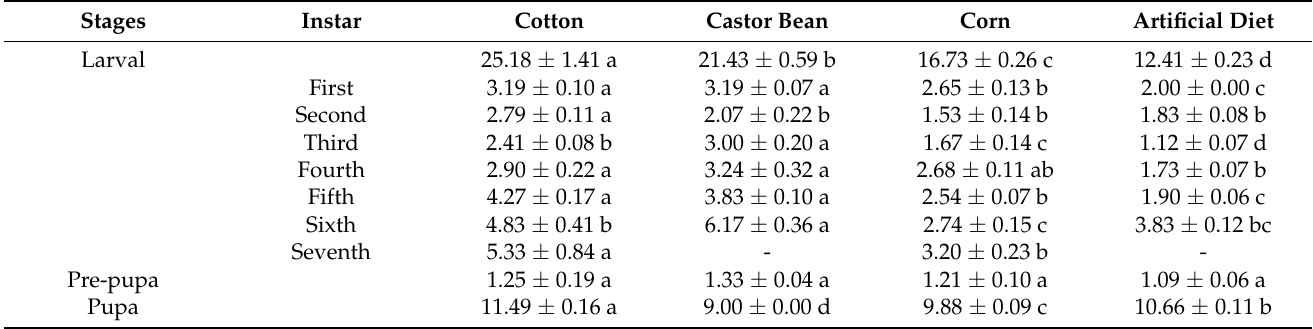
Table 2. Developmental period (days, mean ± standard error) of the larvae stage and of the first, second, third, fourth, fifth, sixth and seventh instars, pre-pupa and pupa of Spodoptera frugiperda (Lepidoptera: Noctuidae) fed with pieces of cotton ( Gossypium hirsutum L.), castor bean ( Ricinus communis L.) and corn ( Zea mays L.) leaves and an artificial diet at 25 ± 2 ◦ C, relative humidity of 60 ± 10 and photophase of 12 h.